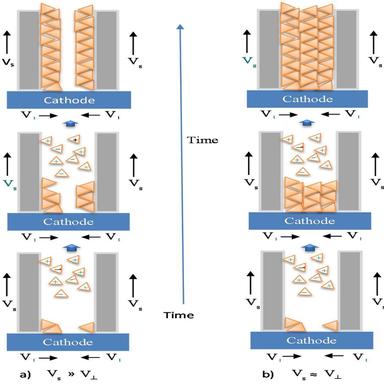
Schematic diagram of the growth mechanism of 1D metal nano-structures via the template-based electrochemical deposition method. (a) Metal nanotube growth steps. (b) Metal nanowire growth steps.